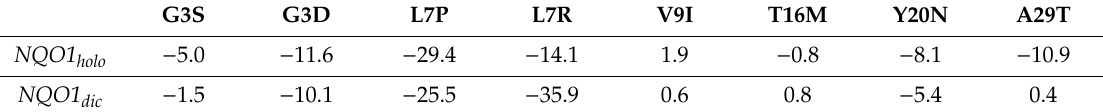
Table 2. Mutational e ff ects on conformational stability (as folding free energy between the mutant and WT proteins, ∆∆ G, in kcal · mol − 1 , in the NQO1 holo and NQO1 dic states, determined by Rosseta).